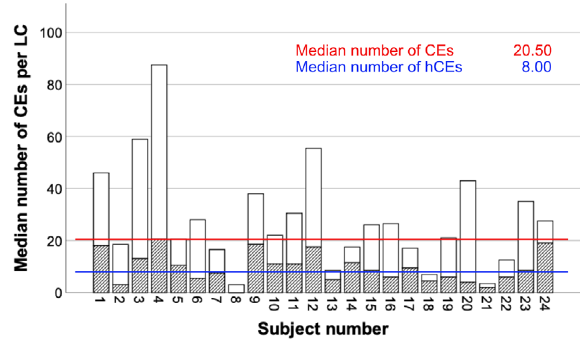
Figure 3. Median number of CEs per LC (white part of column) and proportionally the median number of hCEs per LC (hatched part of column), n = 24 subjects with four LCs each (total 96 LCs with four LCs per